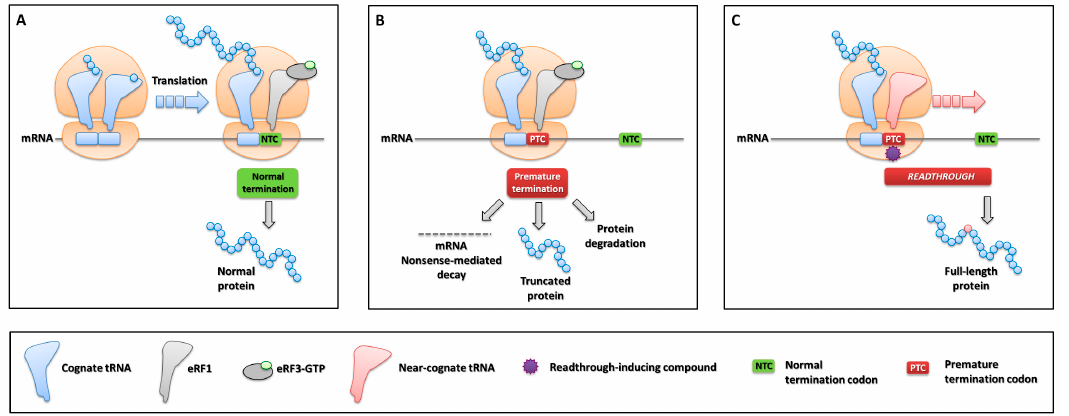
Figure 8. Translation termination and readthrough-mediated PTC suppression. ( A ) Normal translation termination involving eRF1 and eRF3-GTP at 3’ natural stop codons. ( B ) Aberrant translation termination at PTCs and possible outputs resulting from nonsense changes. ( C ) Mechanism of ribosome readthrough resulting in PTC suppression, either spontaneous or induced by compounds, and synthesis of the full-length protein.